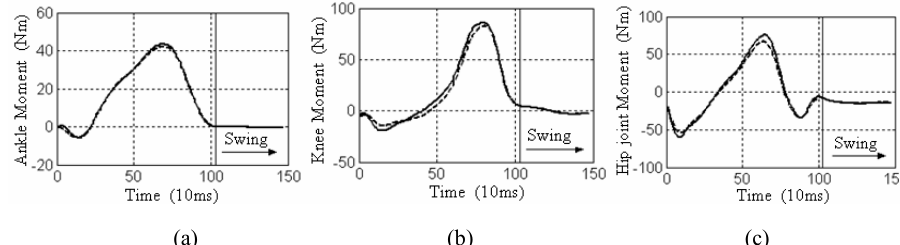
Fig. 5. Joint moments estimated by wearable sensor systems (solid line), and force plate & Hi-DCam camera systems (dashed line). Ankle plantarflexor, knee extensor, and hip flexor are positive, and ankle dorsiflexion, knee flexor, and hip extensor are negative. (a) Ankle moments. (b) Knee moments. (c) Hip joint